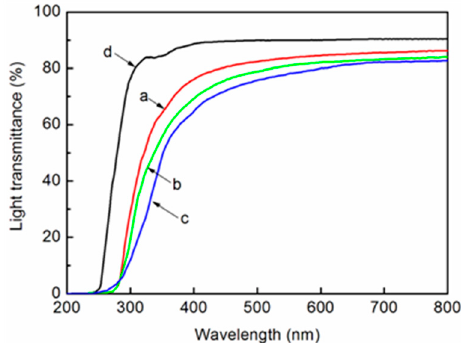
Figure 10. Regular light transmittances of the nanocomposites made with fibrillated (a) CNF-I, (b) CNF-I/II, (c) CNF-II, and (d) acrylic resin.